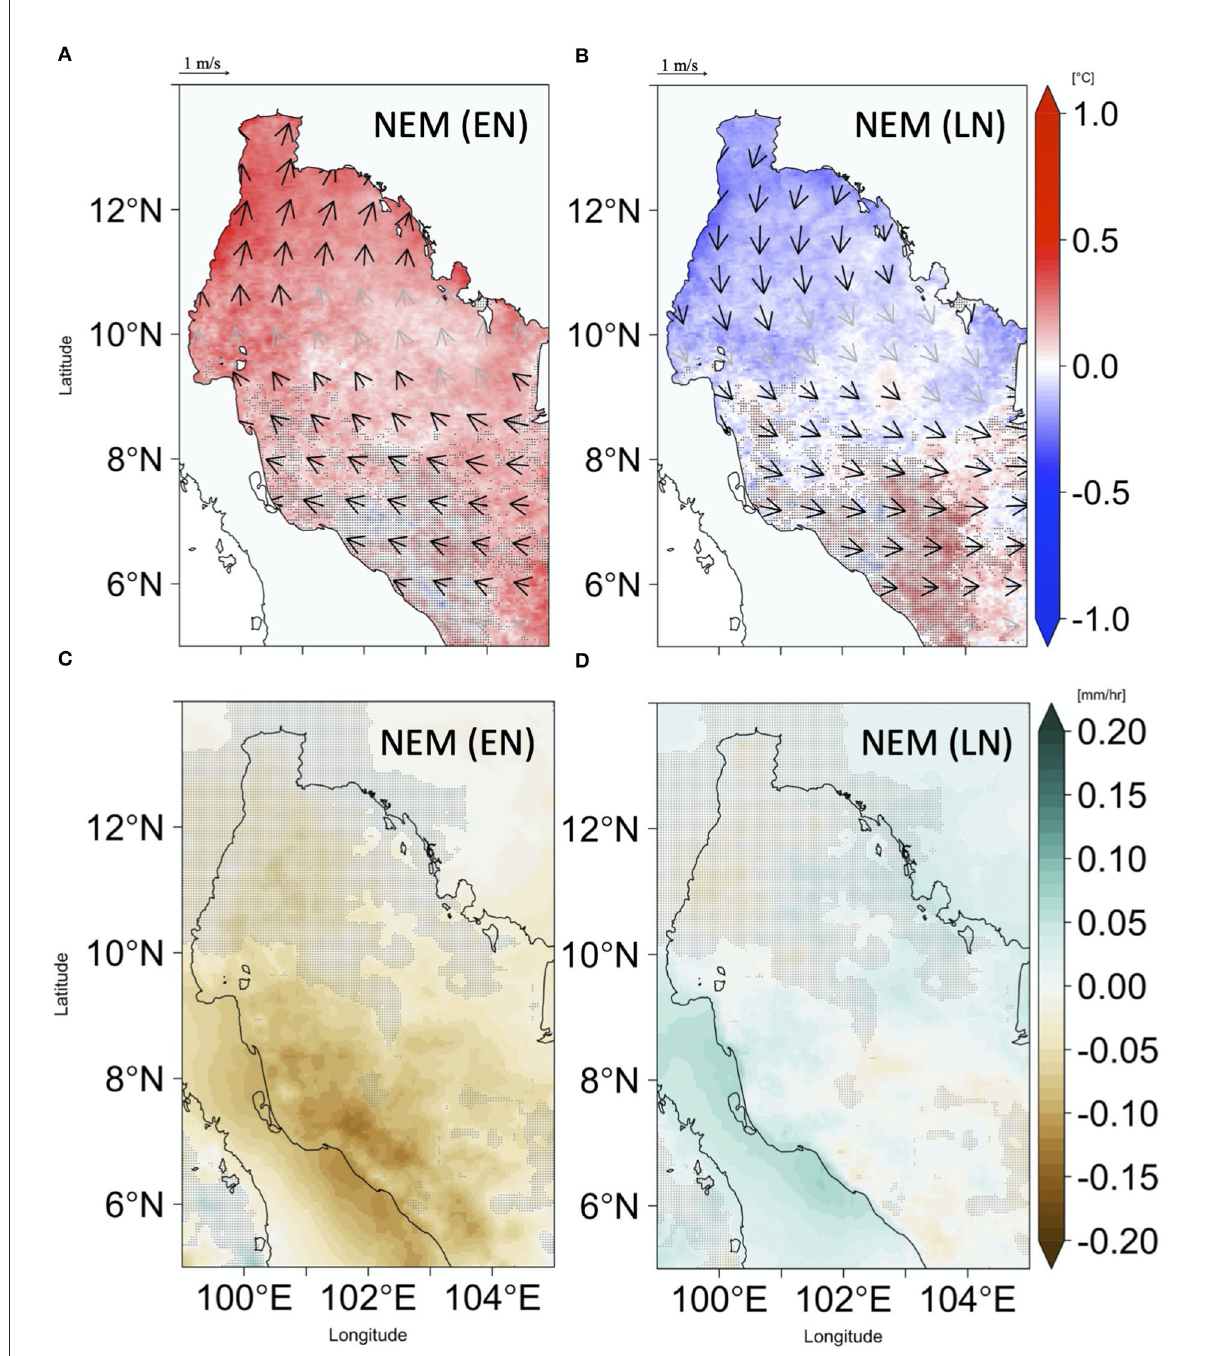
FIGURE8 SST and wind anomalies under EN (A) and LN (B) with precipitation anomaly under EN (C) and LN (D) during NEM. The gray vectors and dots indicate the non-significant level ( p > 0.05) of correlation between the parameter and MEI.